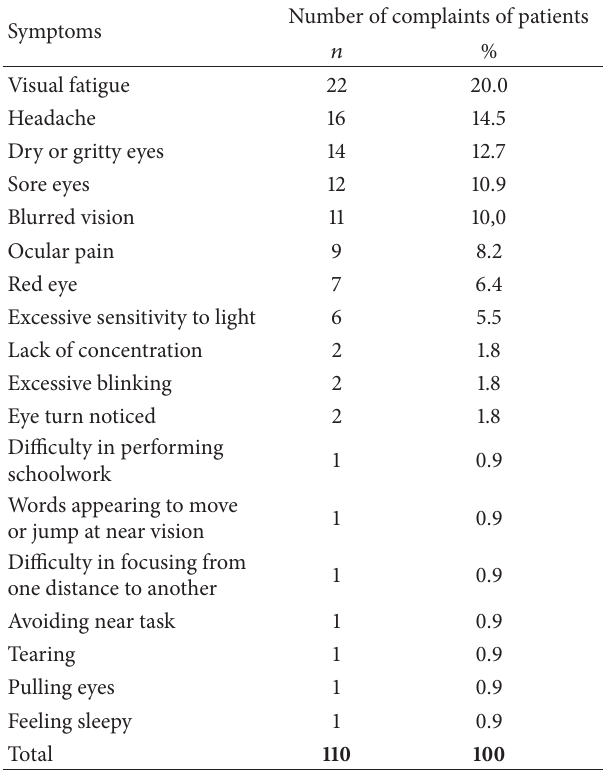
Table 2: Symptoms categories encountered in all subjects of the